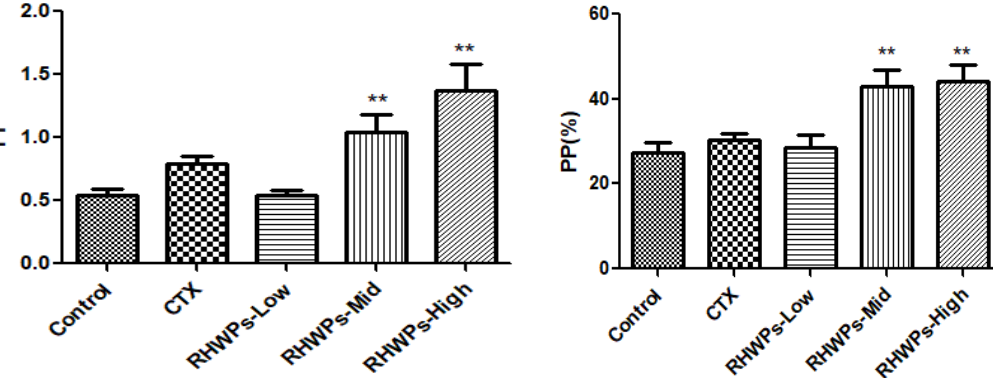
Figure 9. Effect of RHWPs on PP and PI in S180 tumor-bearing mice. The PP and PI are presented as mean ± SD ( n = 10). Note: significant differences from the control groups are designated as ** p < 0.01.